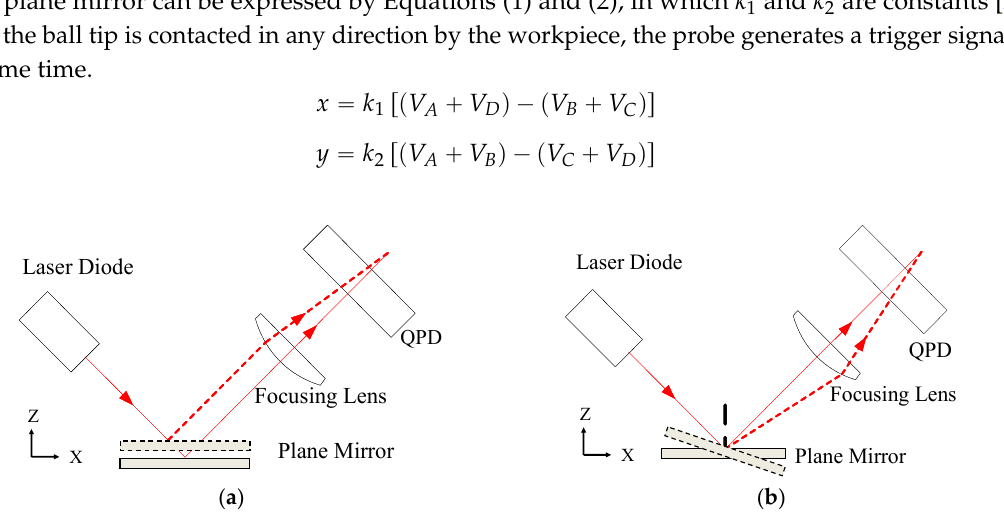
Figure 2. Optical paths of the sensor. ( a ) Mirror in vertical displacement and ( b ) mirror in tilt motion.